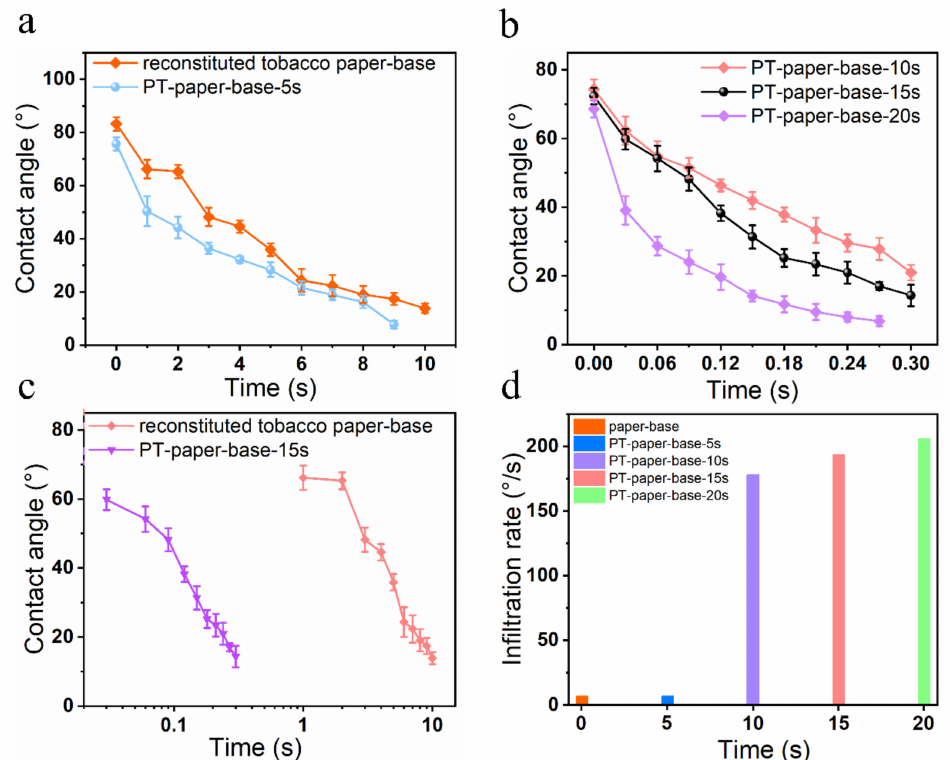
Figure 5. The infiltration contact angle of a water droplet on the surface of different tobacco paper-base sheets. The contact angle comparison of ( a ) reconstituted tobacco paper-base and PT- tobacco-5s, ( b ) PT-tobacco-10 s, PT-tobacco-15 s and PT-tobacco-20 s, ( c ) reconstituted tobacco paper- base and PT-tobacco-15 s; Different mean infiltration rate of ( d ) reconstituted tobacco paper-base, PT-tobacco-5 s, PT-tobacco-10 s, PT-tobacco-15 s and PT-tobacco-20